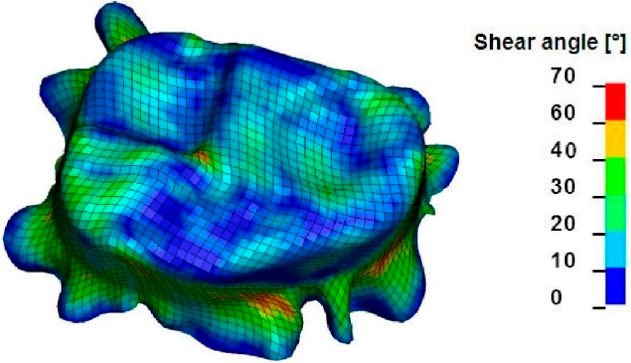
Figure 2. Weaving simulation of a 3D multilayers woven fabric from fiber roving, which are represented by shell elements.